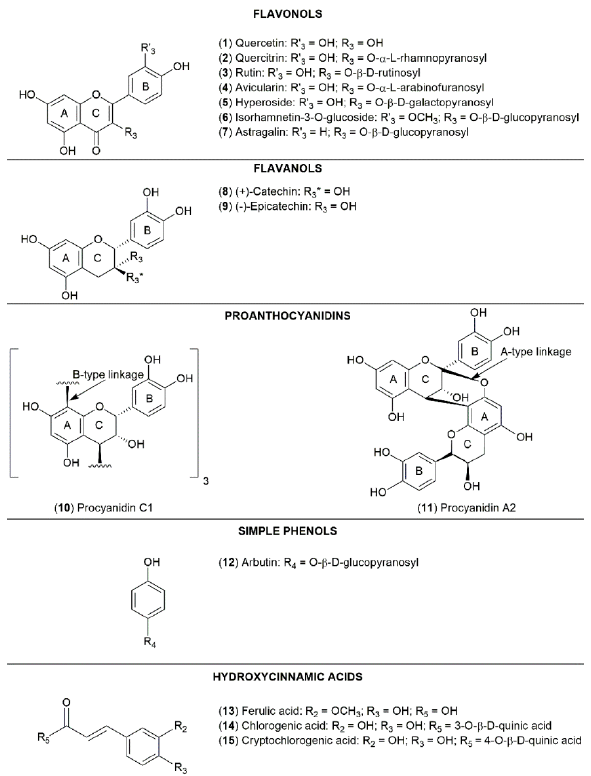
Figure 5. The chemical structures of studied phenolic compounds ( 1 – 15 ).